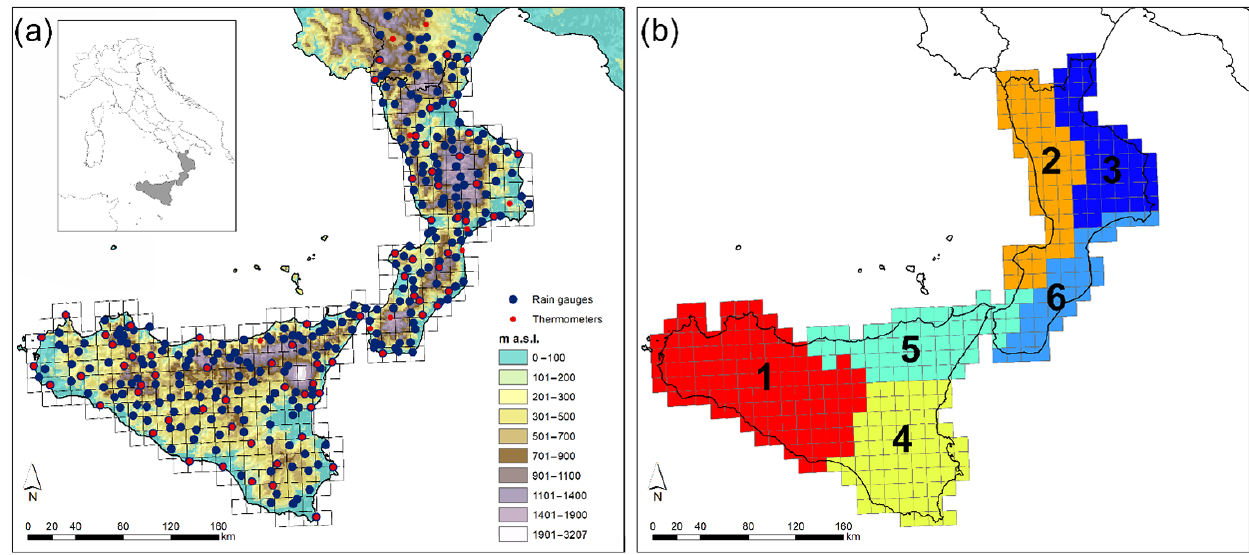
Figure 1. (a) Study area (Calabria is the southernmost peninsula of Italy, and Sicily is the neighbouring island) with the locations of the gauges of the high-density observational network and the CORDEX reference grid; (b) the six homogeneous zones identified through PCA.